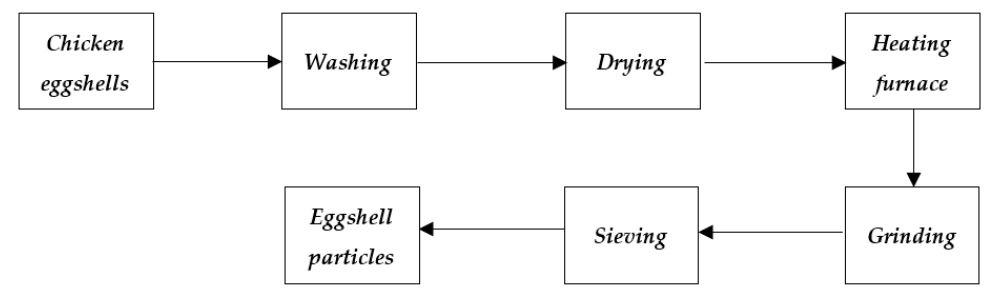
Figure 3. Processing for carbonised eggshell filler.